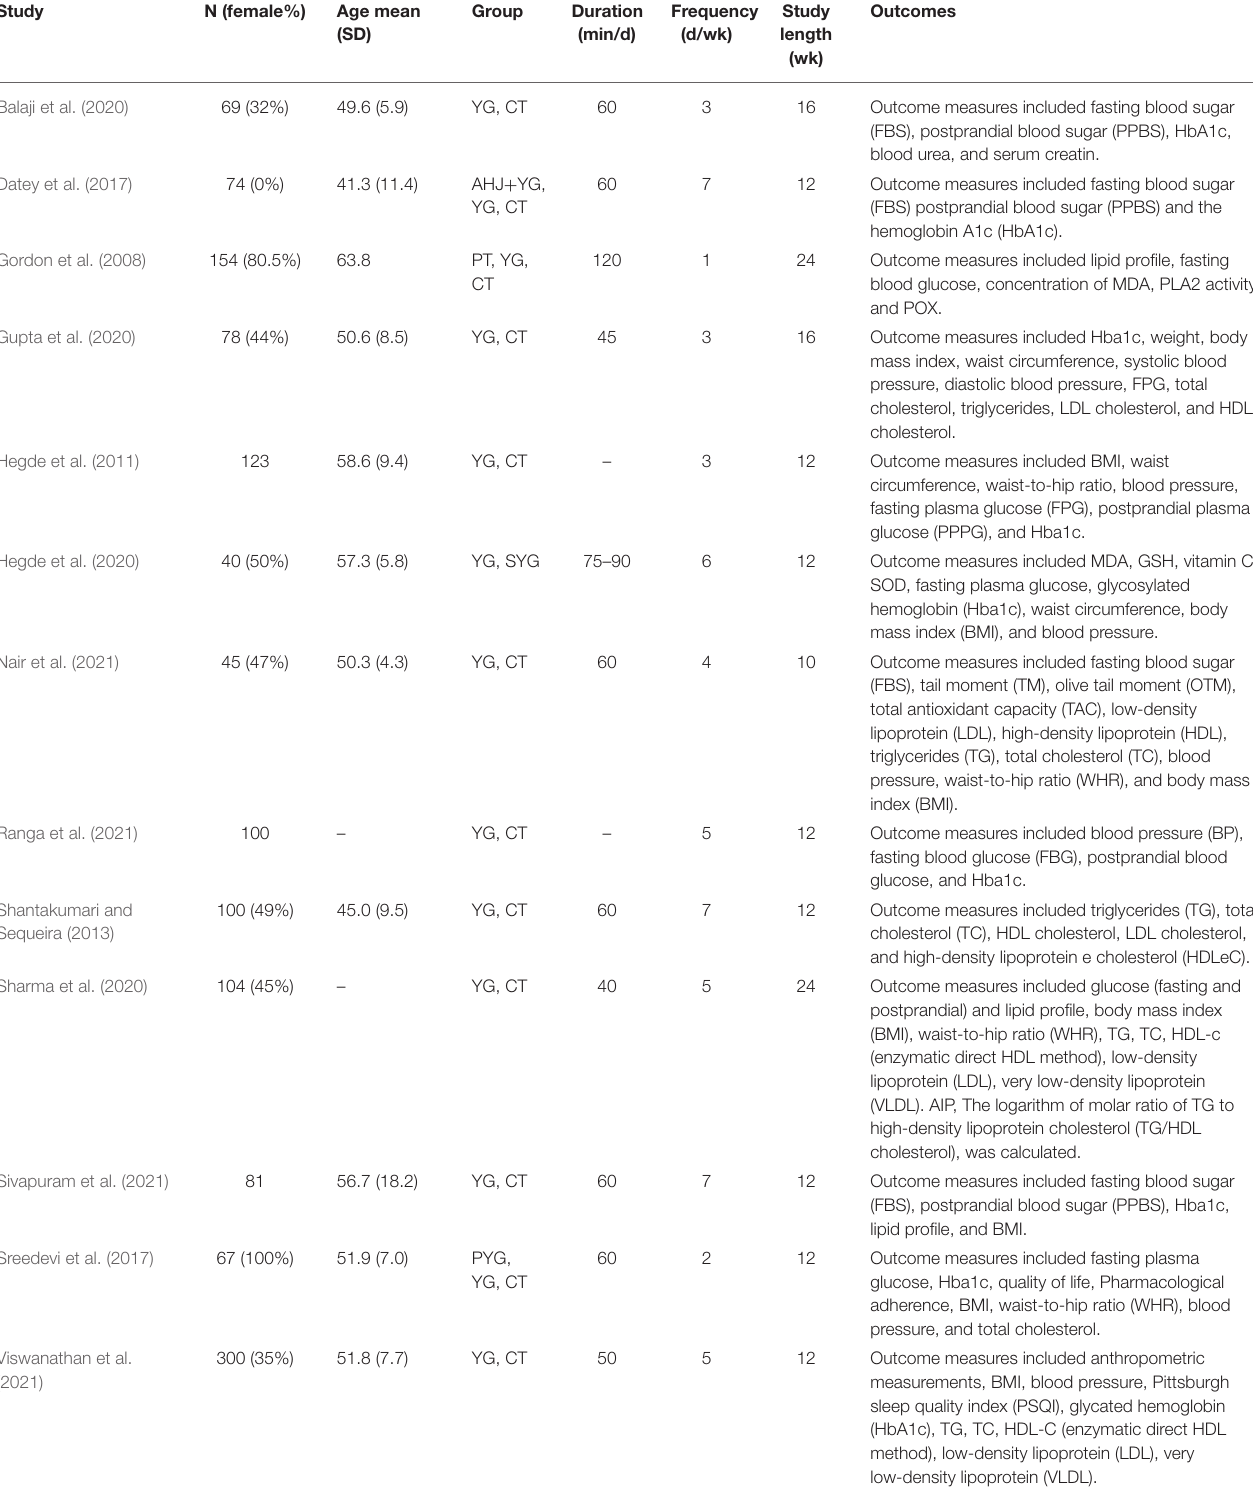
TABLE 1 | Characteristics of the included intervention